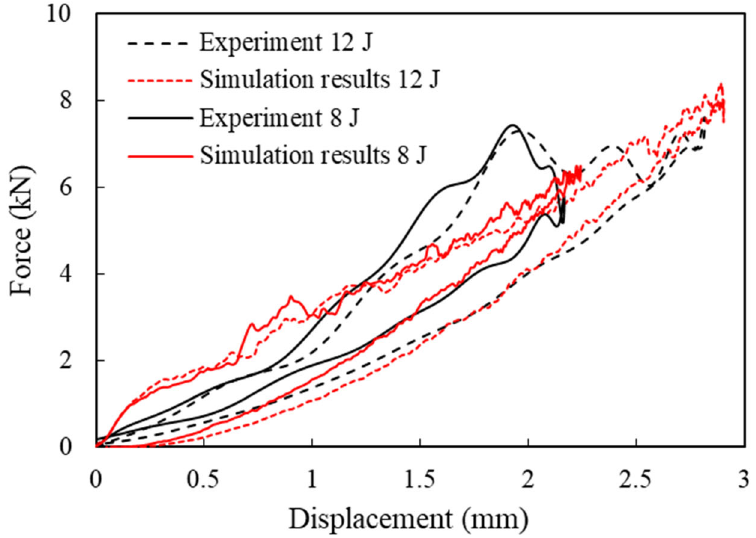
Figure 4. Comparison of experimental and numerical force–displacement curves for a low-velocity impact at 8 J and 12 J on a coupon specimen [29]. Table 3. Comparison of the experimental and numerical absorbed energies and projected delami ‐ nation areas [29].